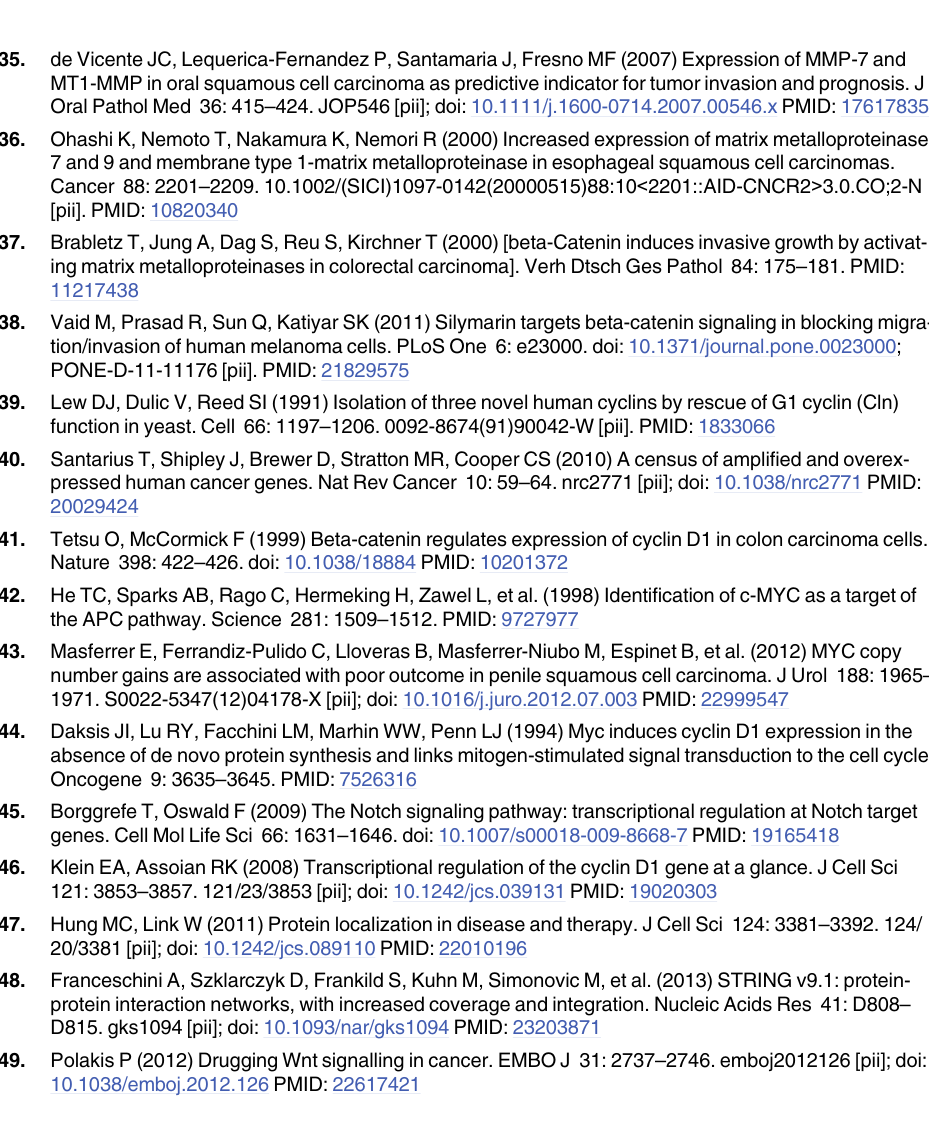
PLOS ONE | DOI:10.1371/journal.pone.0124395 April 22,